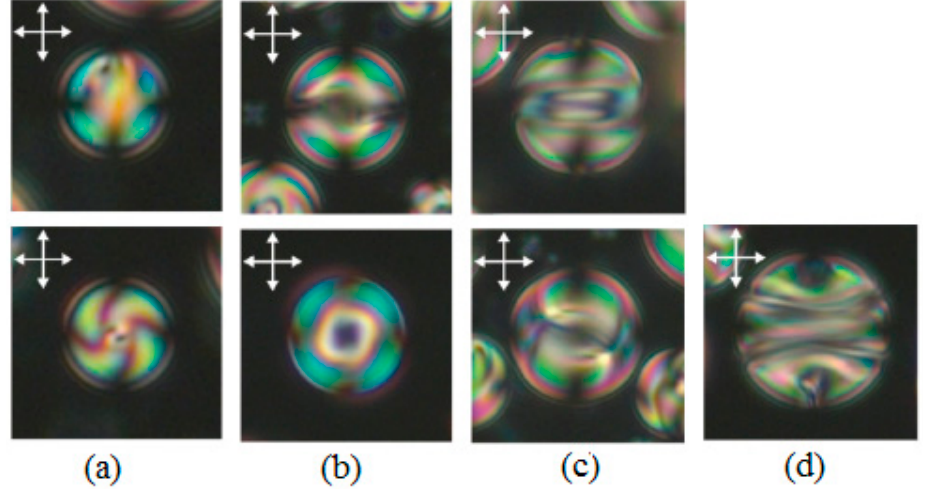
Figure 8. Optical textures taken between the crossed polarizers (double arrows). The symmetry axis was oriented parallel (top row) and perpendicular (bottom row) to the viewing plane. ( a ) A 7.5 µ m droplet (N 0 = 2.7) with the twisted radial structure; ( b ) a 14 µ m droplet (N 0 = 5.1) with the toron-like structure; ( c ) a 15 µ m droplet (N 0 = 5.5) with the intermediate (L 0 ) structure; ( d ) a 17 µ m droplet (N 0 = 6.2) with the layer-like (L) structure. The bipolar axis lies in the plane of the film and the polarizer is aligned perpendicularly to the bipolar axis. Reprinted with permission from ref. [37]. Copyright 2005, the Royal Society of Chemistry.